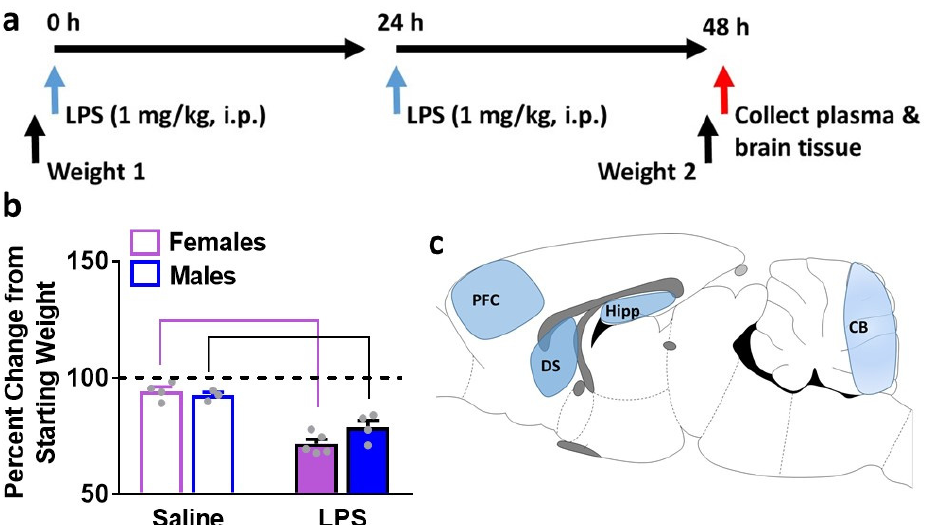
Figure 1. Schematic of the time line of body weight measures, LPS injections, and euthanasia ( a ). Body weight data expressed as percent change in weight 2 from weight 1 ( b ). Sagittal view of the adult rat brain indicating the region of interest for dissections ( c ). Prefrontal cortex, PFC; dorsal striatum, DS; hippocampus, Hipp; cerebellum, CB. Data are represented as mean ± S.E.M. n = 4 control female, n = 5 LPS female, n = 3 control male, n = 4 LPS male. p < 0.05 vs. controls by post-hoc tests.